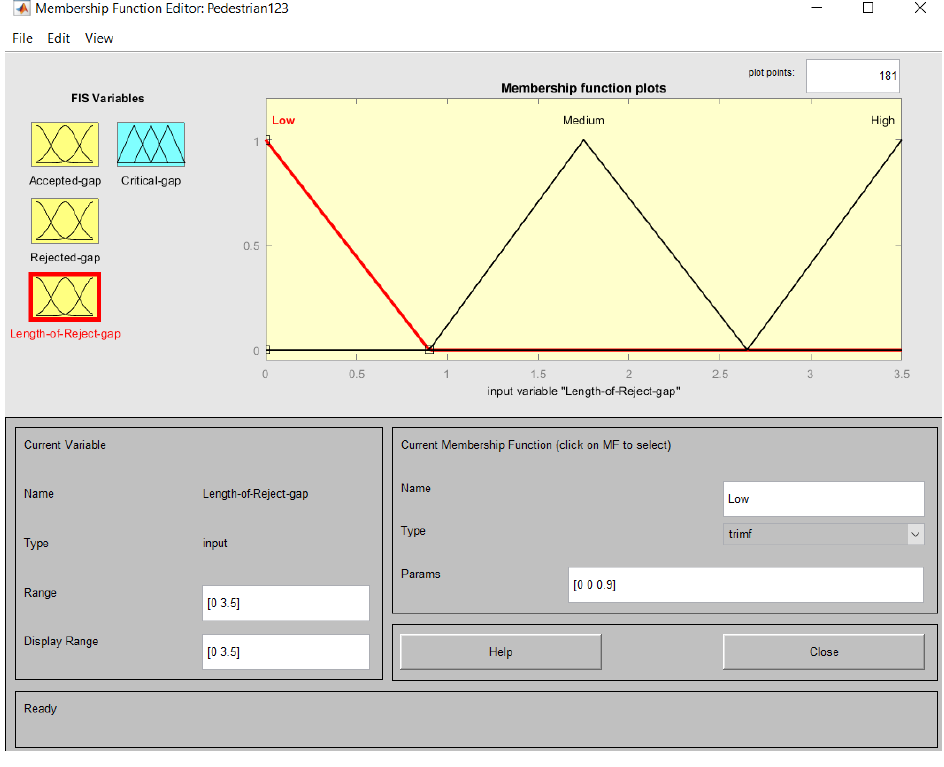
Figure 5. Low, medium and high ranges for inputs. Appl. Sci. 2020 , 10 , x FOR PEER REVIEW